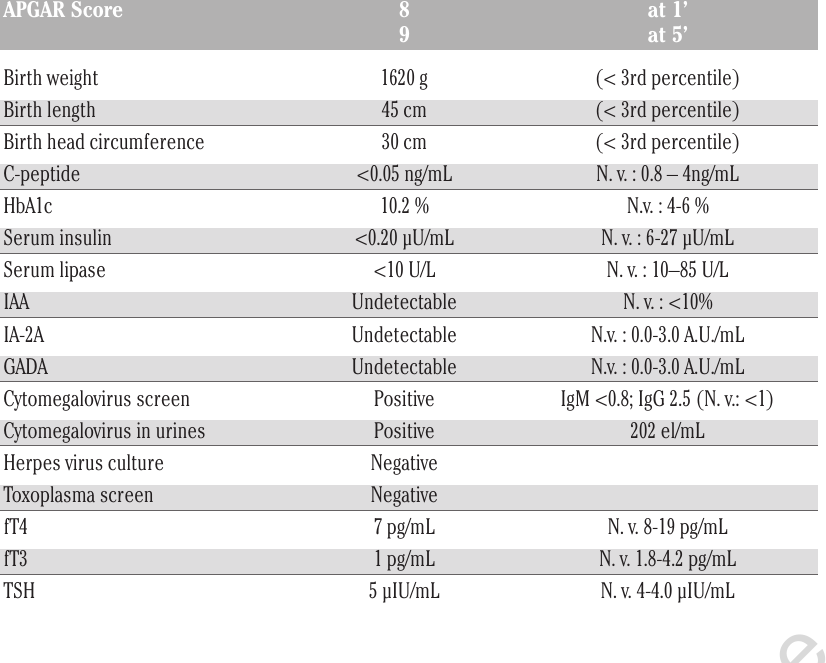
Table 1. Clinical characteristics and main laboratory data of the patient. APGAR